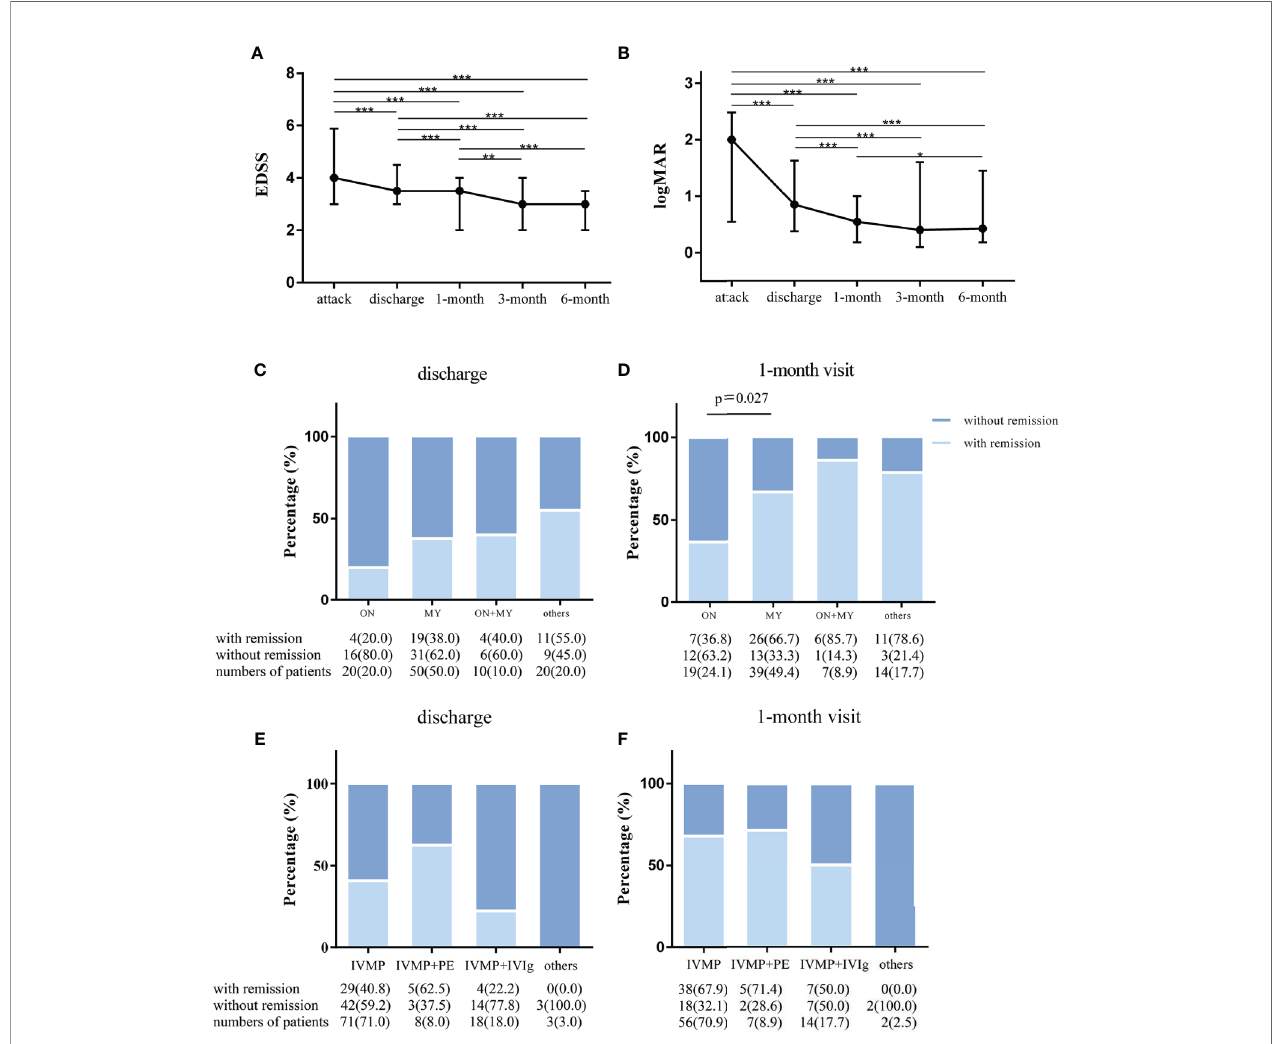
FIGURE 3 | The outcome of attacks of NMOSD patients. Changes in expanded disability status scale (EDSS) scores and visual acuities in NMOSD patients from acute attacks to 6-month follow-up. (A) EDSS scores were compared in all matched patients corresponding to 4 time points in the whole cohort. (B) The values of visual acuities of the affected eyes were recorded as Snellen charts and transformed to logMAR values in patients with optic neuritis attacks. Paired Wilcoxon signed rank test was used for statistical analysis; and remission rates categorized by clinical manifestations and therapeutic methods in the cohort. (C) Remission status at discharge (n = 100) and (D) at the 1-month visit (n = 79) in isolated myelitis (MY), isolated optic neuritis (ON), simultaneous MY plus ON (MY+ON) and other subtypes. (E) Remission rates at discharge (n = 100, E ) and at the 1-month visit (n = 79, F ) with treatment with intravenous methylprednisolone pulse therapy (IVMP), IVMP combined with plasma exchange (IVMP+PE) IVMP combined with intravenous immunoglobulin (IVMP+IVIg) and other drugs. Fisher ’ s exact test was used for statistical analysis. *p < 0.05, **p < 0.01, ***p <